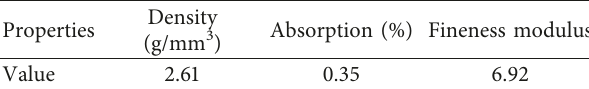
Table 3: Physical properties of coarse